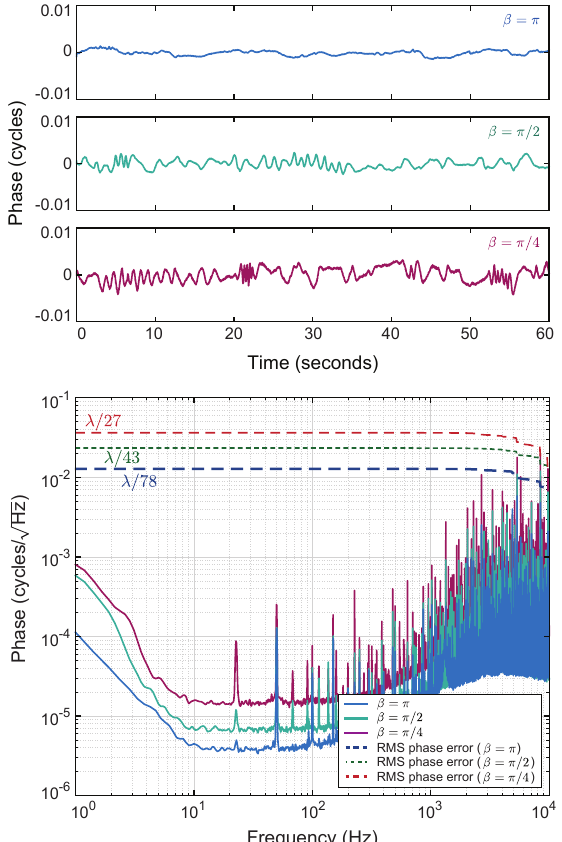
Figure 15. Time-series’ and RPSDs of the OPA’s measured output phase for different PRBS modulation depths. The time measurements shown in the upper panel have been low-pass filtered to reveal the underlying cyclic phase